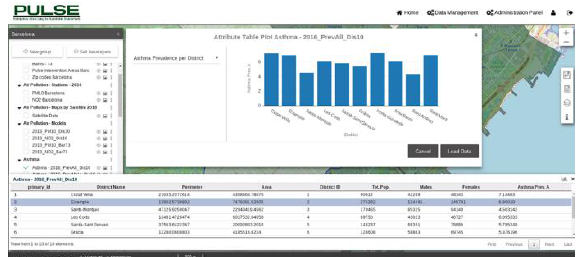
Figure 6. Attribute table